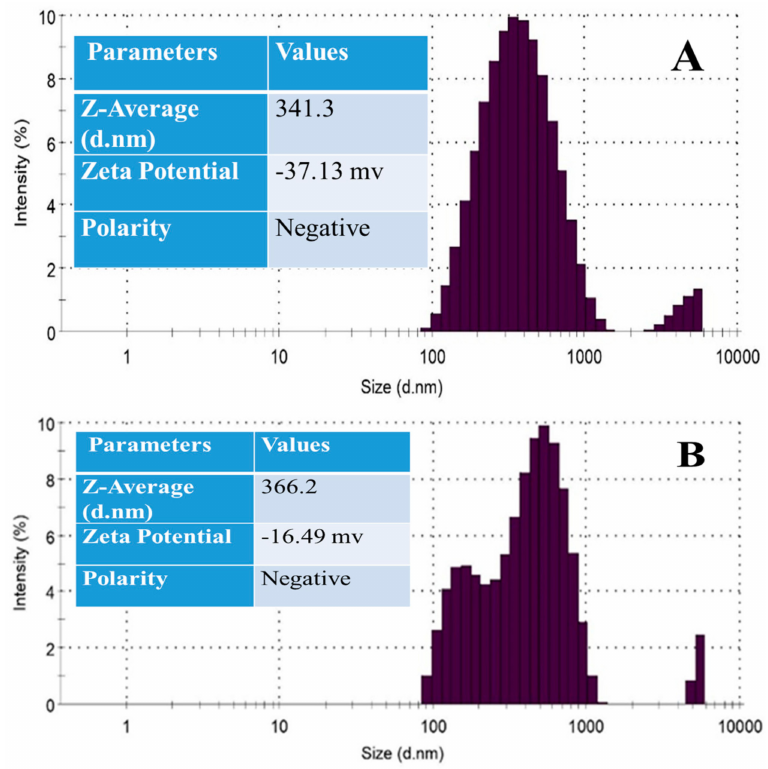
Figure 4. PSA graph of ( A ) MMT clay and ( B ) MMT/Ag nanocomposite.